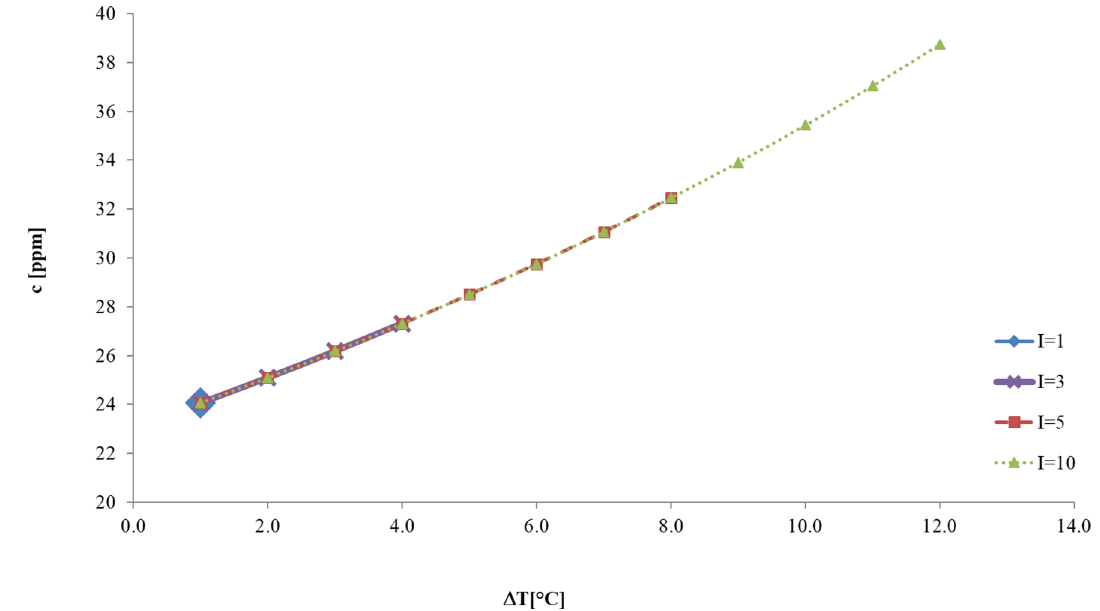
Fig. 8 Ammonia concentration in recovered water as a function of feed cooling gradient (ΔT) and sweeping factor ( I ) for configuration 2. (Feed